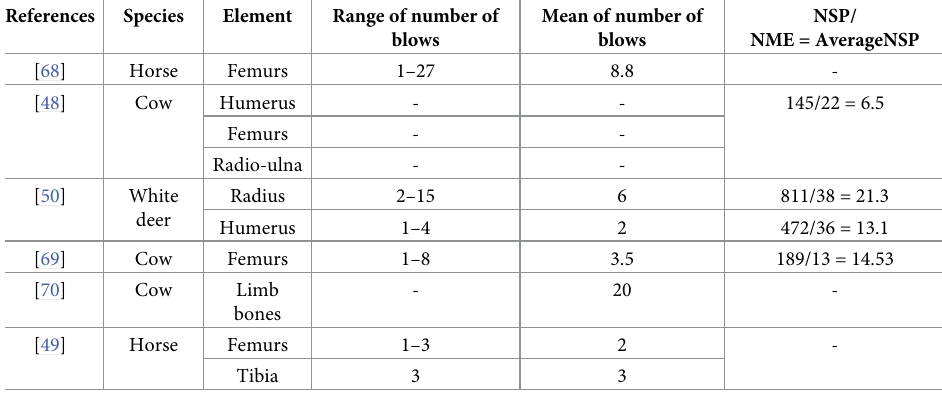
Table 7. Listing of different experiment of bone breakage for marrow extraction and comparing